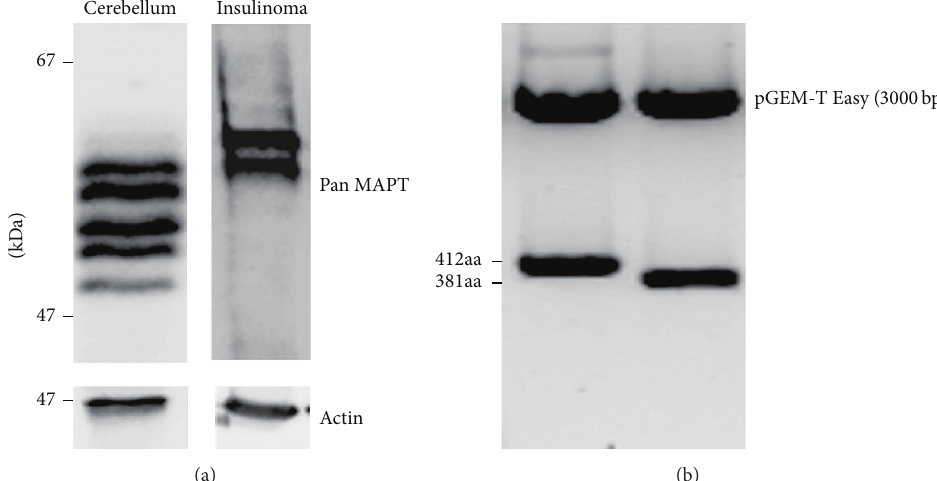
Figure 2: MAPT protein appearance at insulinoma tissue. (a) Comparison of MAPT protein electrophoretic pattern (10% SDS-PAGE gel) from cerebellum and human insulinoma tissue. (b) Subcloned insulinoma tumor cDNA into the pGEM-T Easy replication plasmids. Lower bands demonstrate inserts which contained exclusively the coding region of MAPT3 or MAPT4.